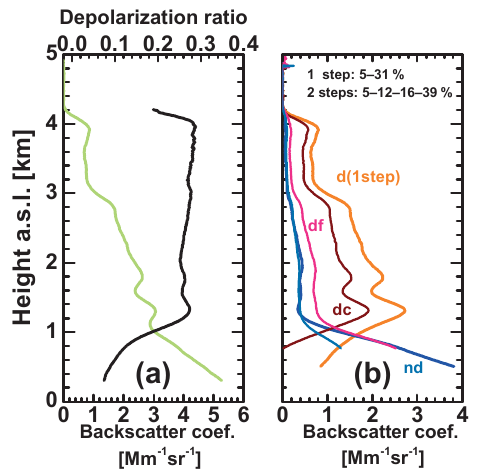
Figure 9. Dust backscatter profiles (in b ) obtained by means of the one-step (d(1-step), total dust, orange) and the two-step POLIPHON method (df, fine dust, pink; dc, coarse dust, dark red) applied to the 532nm polarization lidar observation of the particle backscatter coefficient (green in panel a ) and particle linear depo- larization ratio (black in panel a ) as already shown in Fig. 7. The non-dust backscatter coefficient profiles (nd in panel b ; thick blue is the one-step method; blue is the two-step method) are shown in addition. The one-step method makes use of the characteristic depo- larization ratios of 5 (non-dust) and 31% (dust), whereas the two- step method assumes a height-independent non-dust plus fine-dust depolarization ratio ( δ dn + df ) of 12% and coarse dust depolarization ratio ( δ dc ) of 39% in the first round of the retrieval. In the second round, the non-dust depolarization ratio ( δ nd ) of 5% and the fine dust depolarization ratio ( δ df ) of 16% are used to separate non- dust and fine dust backscatter fractions. Solutions of the two-step method are shown for heights > 750m (i.e., only for heights with coarse dust (dc) backscatter coefficients > 0Mm − 1 sr − 1